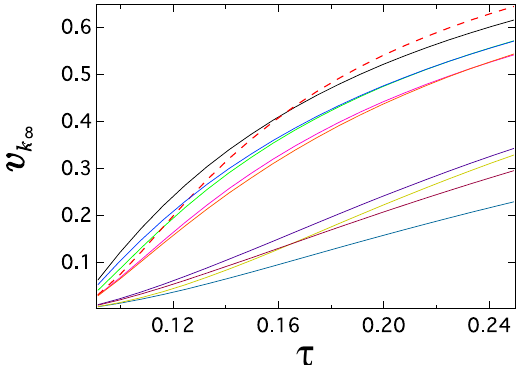
τ Figure 1. The meta-stable infection probabilit v k ∞ as a function of the effective infection rate τ for 10 random nodes in a real-world network called Roget (details in Section “Real-world graph” of the supplementary information). The meta-stable infection probability v k ∞ is obtained by solving